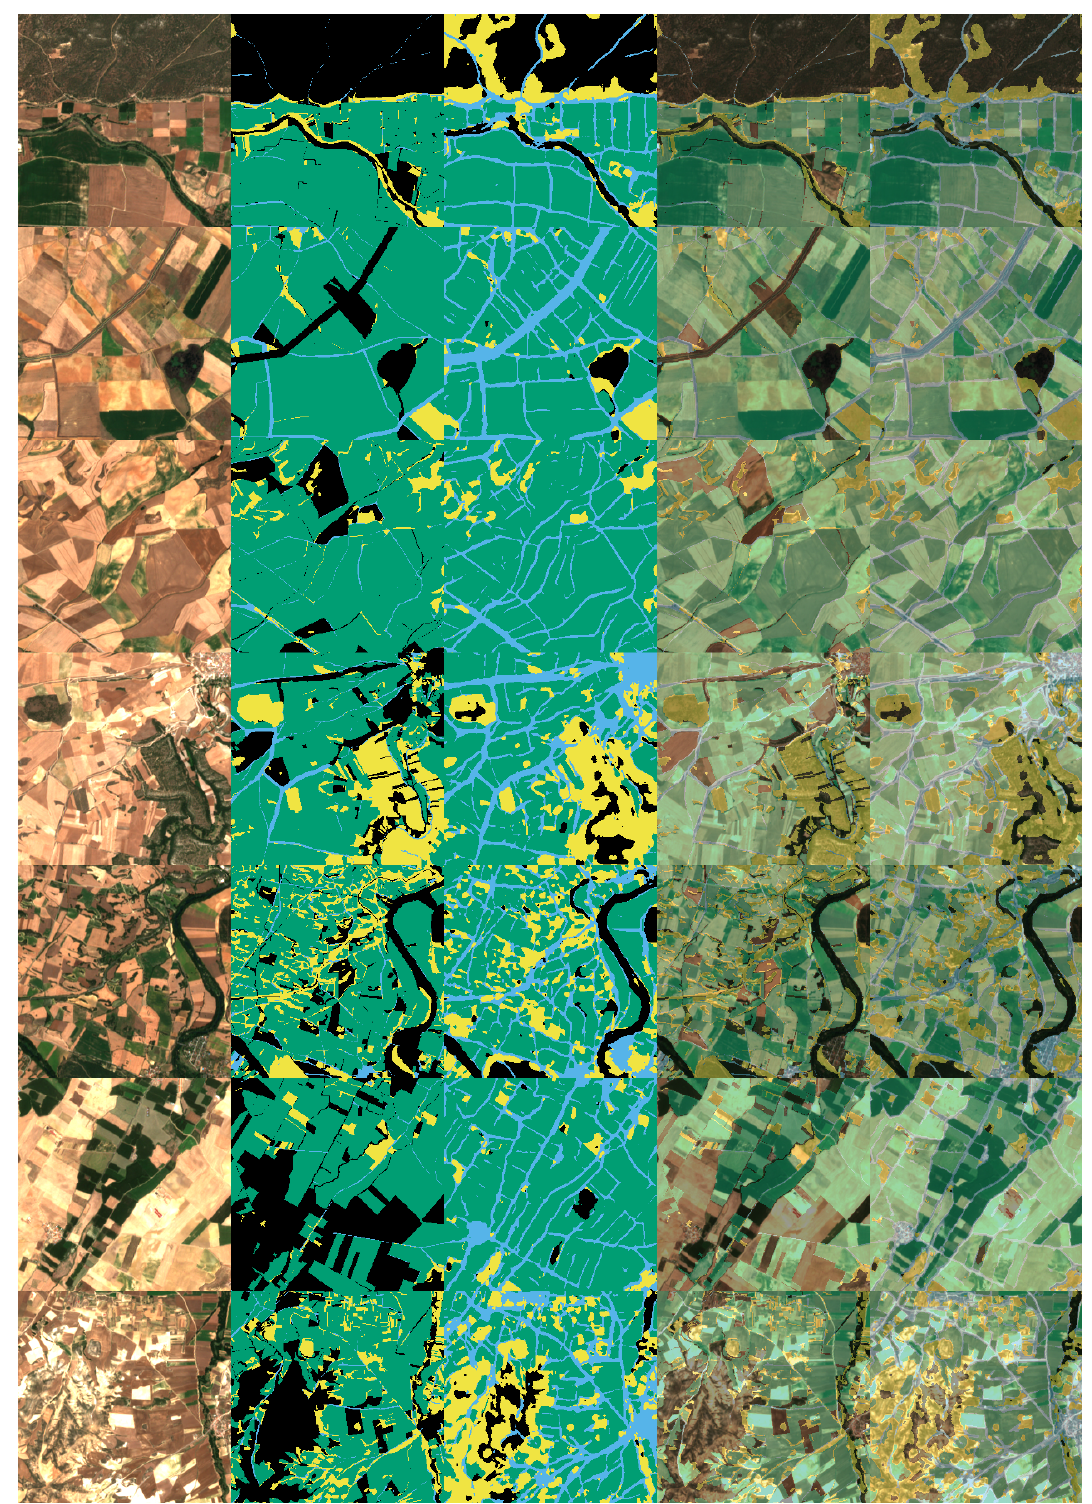
Figure 18. Visualization of the predicted results for UNet evaluated in UOS2 with four classes and “Other” class (Experiment All-Purpose). ( 1st col. ) Original images, ( 2nd col. ) ground truth masks, ( 3rd col. ) predictions, ( 4th col. ) overlapping of original images with ground truth masks, ( 5th col. ) overlapping of original images with